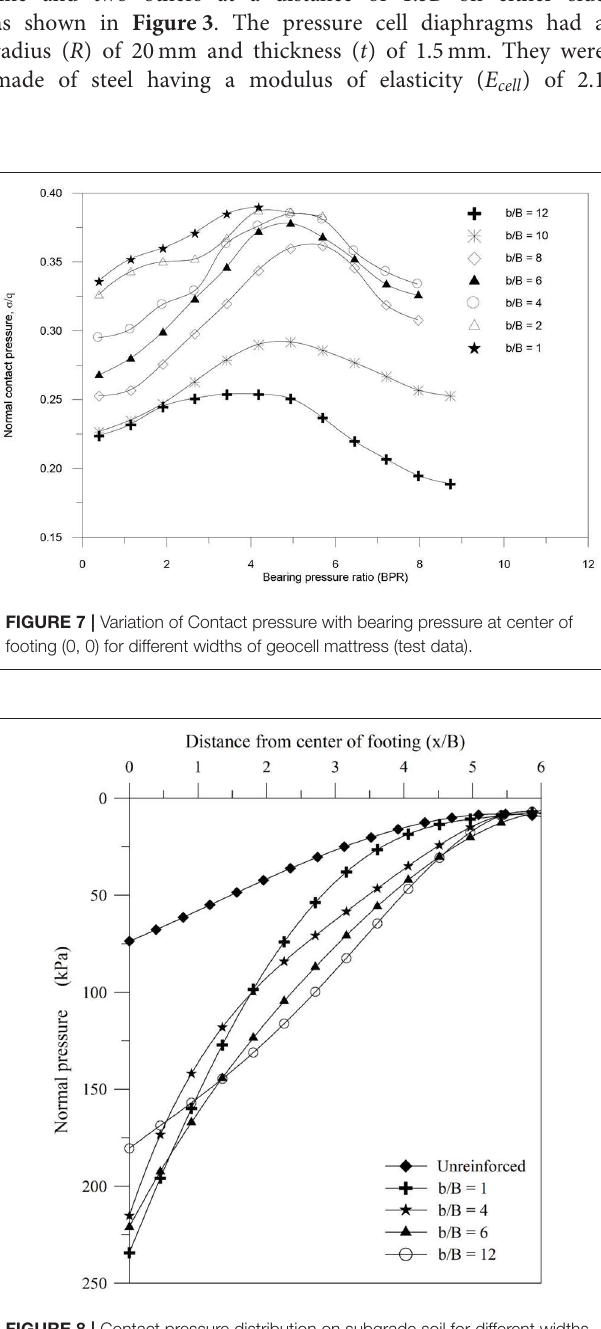
FIGURE 8 | Contact pressure distribution on subgrade soil for different widths of geocell mattress (FEM data, s/B = 20%).